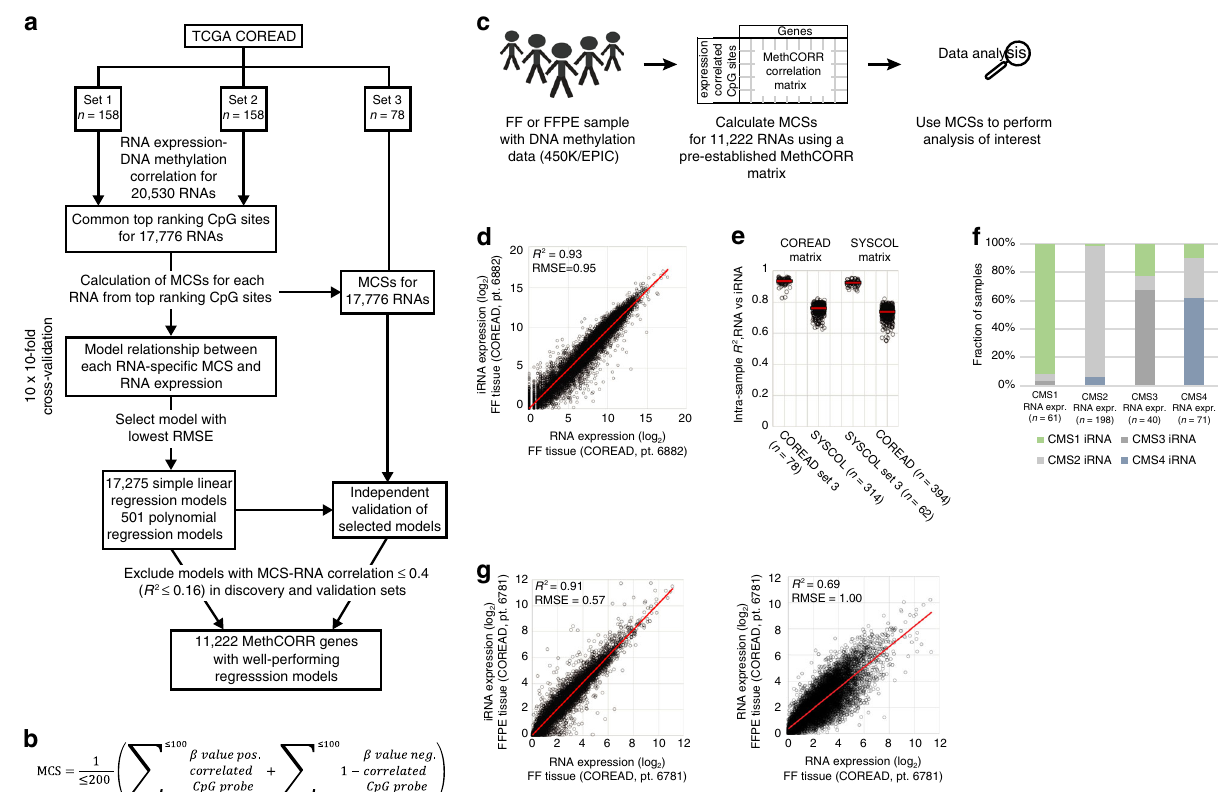
Fig. 1 Development of the MethCORR approach, MethCORR scores, and inferring of RNA expression. a Overview of MethCORR development in the COREAD cohort using matched RNA-sequencing and 450K methylation data. The cohort was divided into two discovery sets (each n = 158) and one validation set ( n = 78). Genome-wide RNA expression-DNA methylation correlations were identi fi ed in each discovery set and shared top expression- correlated CpGs for each RNA were selected ( ≤ 100 positively and ≤ 100 negatively correlated CpGs; Spearman ’ s correlation P value < 0.01). A MCS was calculated for each gene using DNA methylation β -values of expression-correlated CpGs and the formula given in ( b ). RNA expression of each gene was modeled from its MCS using simple linear- and polynomial regression models and 10 × 10-fold cross validation in set 1 + 2. Simple linear models were selected for all RNAs except when polynomial models exhibited a ≥ 5% decrease in RMSE values (Supplementary Fig. 1d). Only models with R 2 > 0.16 between inferred RNA (iRNA) and observed RNA expression in both the discovery set and the independent validation set 3 was kept for further analysis ( n = 11,222, termed MethCORR genes). b Formula for calculating MCSs from DNA methylation β -values. c Overview of MethCORR applications. Fresh- frozen (FF)/FFPE CRC samples with 450K/EPIC methylation pro fi les can be applied to the MethCORR matrix for calculation of MCSs and iRNA expression. d Scatterplot showing intra-sample correlation between iRNA and RNA expression in a representative COREAD validation sample. e Plot showing R 2 of intra-sample iRNA and RNA expression correlations for all samples of the COREAD validation set 3 and SYSCOL cohort when using the COREAD-derived MethCORR matrix (left) and for all samples of the SYSCOL validation set 3 and COREAD cohort when using the SYSCOL-derived MethCORR matrix (right). f Histogram showing overlap in CMS subtype predictions in COREAD CRC samples using RNA expression or iRNA expression for classi fi cation. g Scatterplot showing intra-sample correlation between iRNA (left) or RNA expression (right) from a FFPE sample and RNA expression in a matched fresh- frozen COREAD